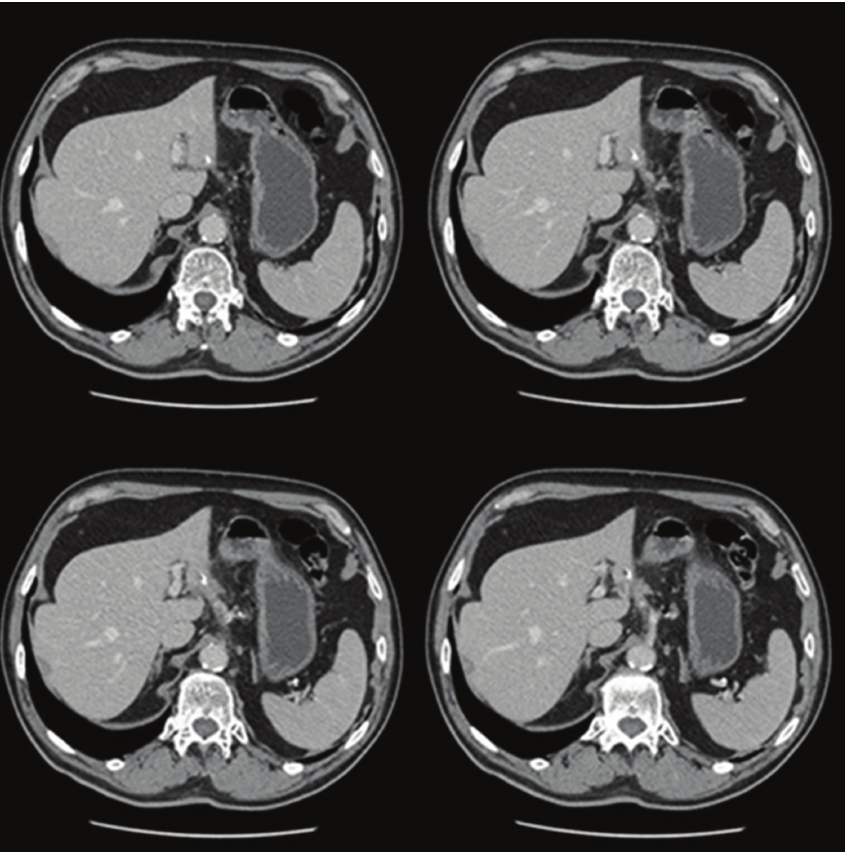
Figure 1: CT scan: presence of a linear radiopaque structure 3cm in length at the inferior margin of left lobe of the liver.